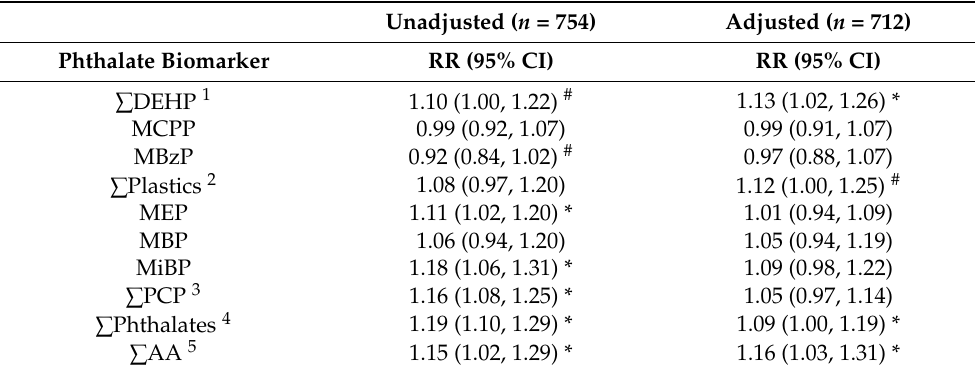
Table 2. Associations between phthalate biomarker concentrations and diagnosis of uterine